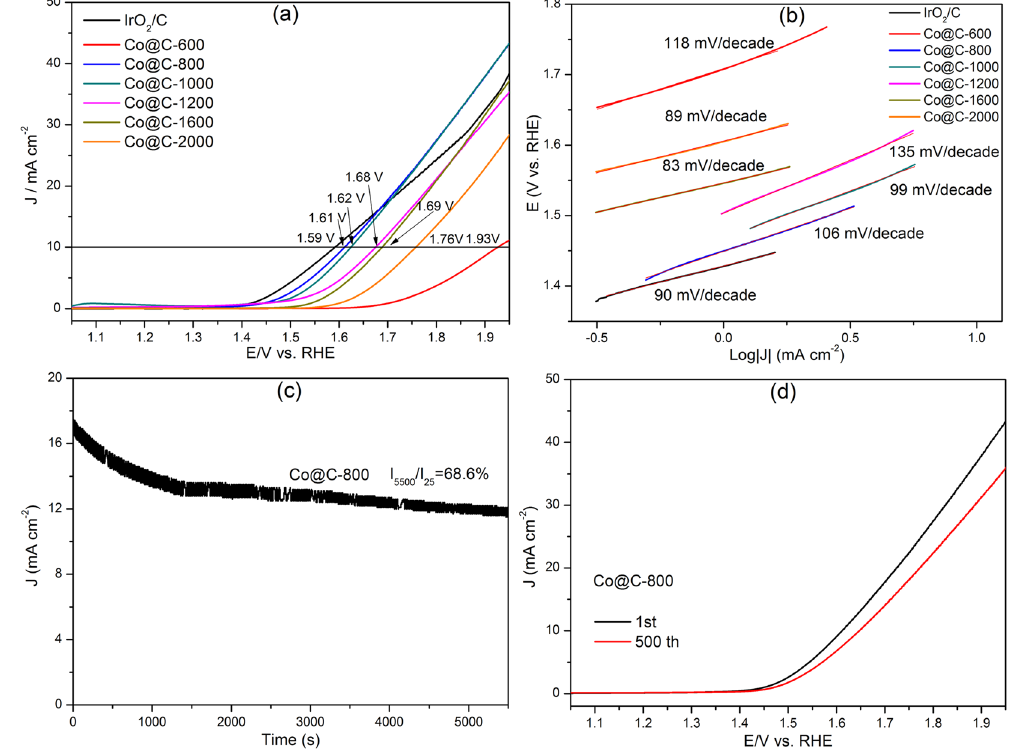
Figure 7. ( a ) LSV curves and ( b ) the corresponding Tafel plots of the as-synthesized Co@C composites and IrO 2 /C at 5 mV s − 1 . ( c ) Chronoamperometric response for Co@C-800 at 1.7 V. ( d ) Polarization curves of Co@C- 800 before and after 500 scan